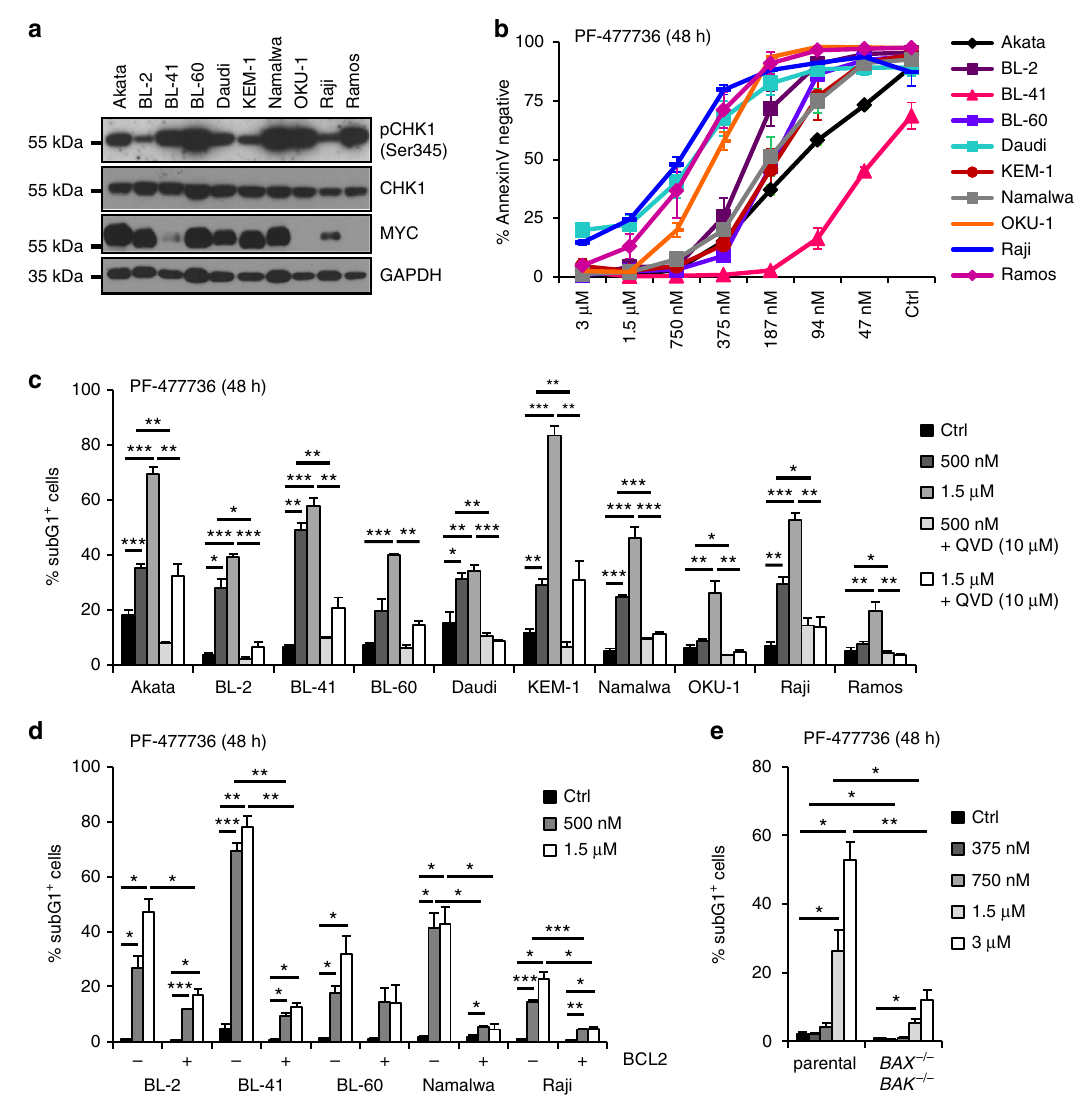
Fig. 1 Inhibition of CHK1 results in BCL2-regulated cell death. a Western blot analysis showing the expression and activation status of CHK1 (pSer345) as well as MYC levels in ten different Burkitt lymphoma cells lines. b Dose response of Burkitt lymphoma cells lines to Chk1 inhibitor PF-477736. Survival was assessed using AnnexinV-staining and fl ow cytometry. c Burkitt lymphoma cells lines were treated for 48 h with the CHK1 inhibitor PF-477736 (CHK1i), either alone or in combination with the pan-caspase inhibitor QVD. Cells were processed for sub-G1 analysis using propidium iodide (PI) staining and fl ow cytometry. d Selected Burkitt lymphoma cell lines were transduced with a retrovirus enabling overexpression of anti-apoptotic BCL2 or an empty control vector. Cell death was assessed after 48 h of CHK1i treatment by sub-G1 analysis. e Nalm6, human B cell precursor acute lymphocytic leukemia (pre-B ALL) cells, were used to knock-out BAX and BAK using CRISPR/Cas9-based genome editing. The sub-G1 fraction of cells was determined by fl ow cytometry 48 h after CHK1i treatment. Bars represent means of n = 3/treatment ± S.E.M. * p < 0.05, ** p < 0.01, *** p < 0.001 using unpaired Student ´ s t